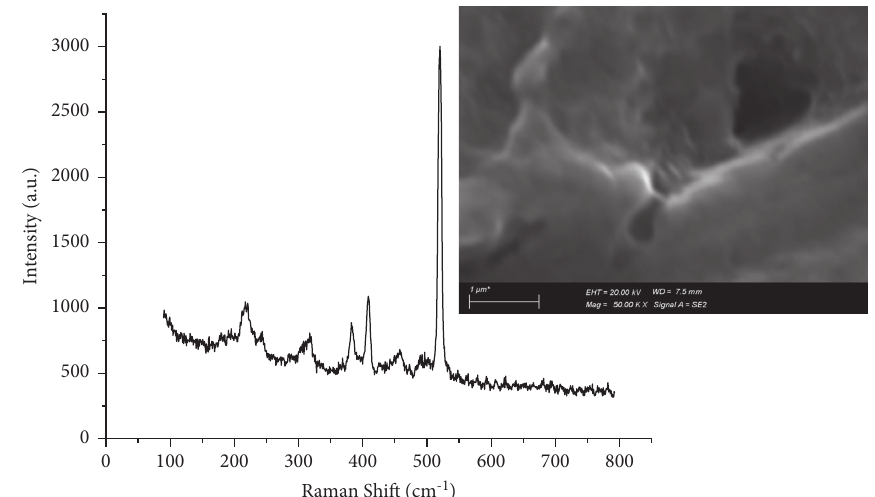
Figure 4: Raman spectrum of MoS